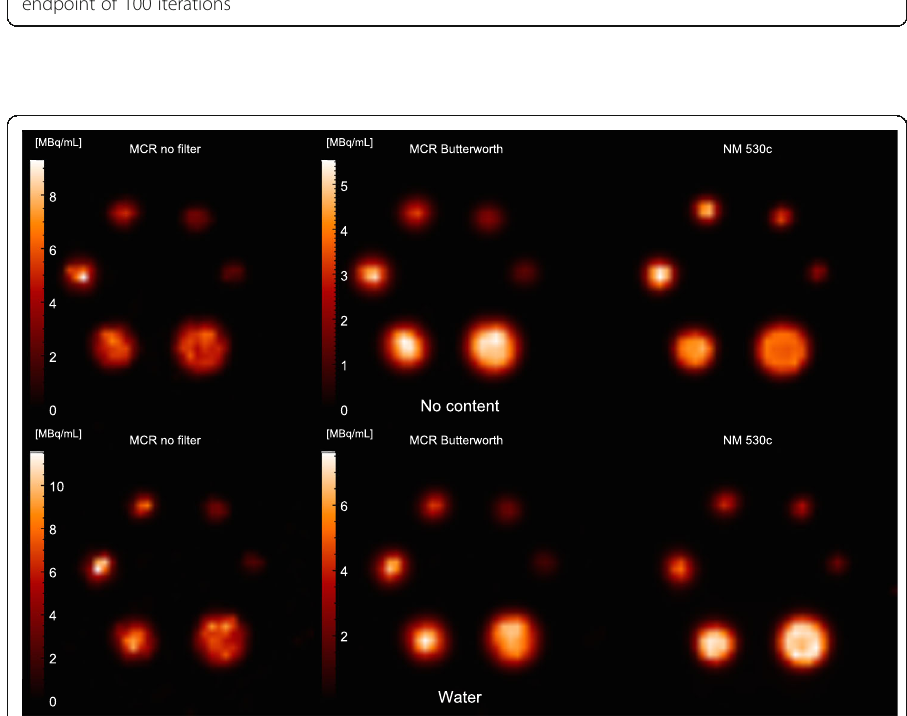
Fig. 5 Maximum-intensity projection images for spheres in empty (top) and water-filled (bottom) torsos reconstructed using 40 iterations of MCR (left and middle) and NM 530c reconstruction (right). The activity concentrations were 3.8 and 4.1 MBq/mL at the start of the measurement for the spheres in the empty and water-filled torsos, respectively. The sphere volumes were 16, 8, 4, 2, 1, and 0.5 mL, moving clockwise from the lower-right sphere in each image. MCR images are shown with and without Butterworth